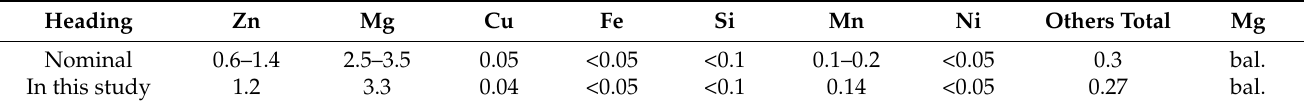
Table 1. Chemical composition of AZ31 rectangular workpieces (wt. s%).